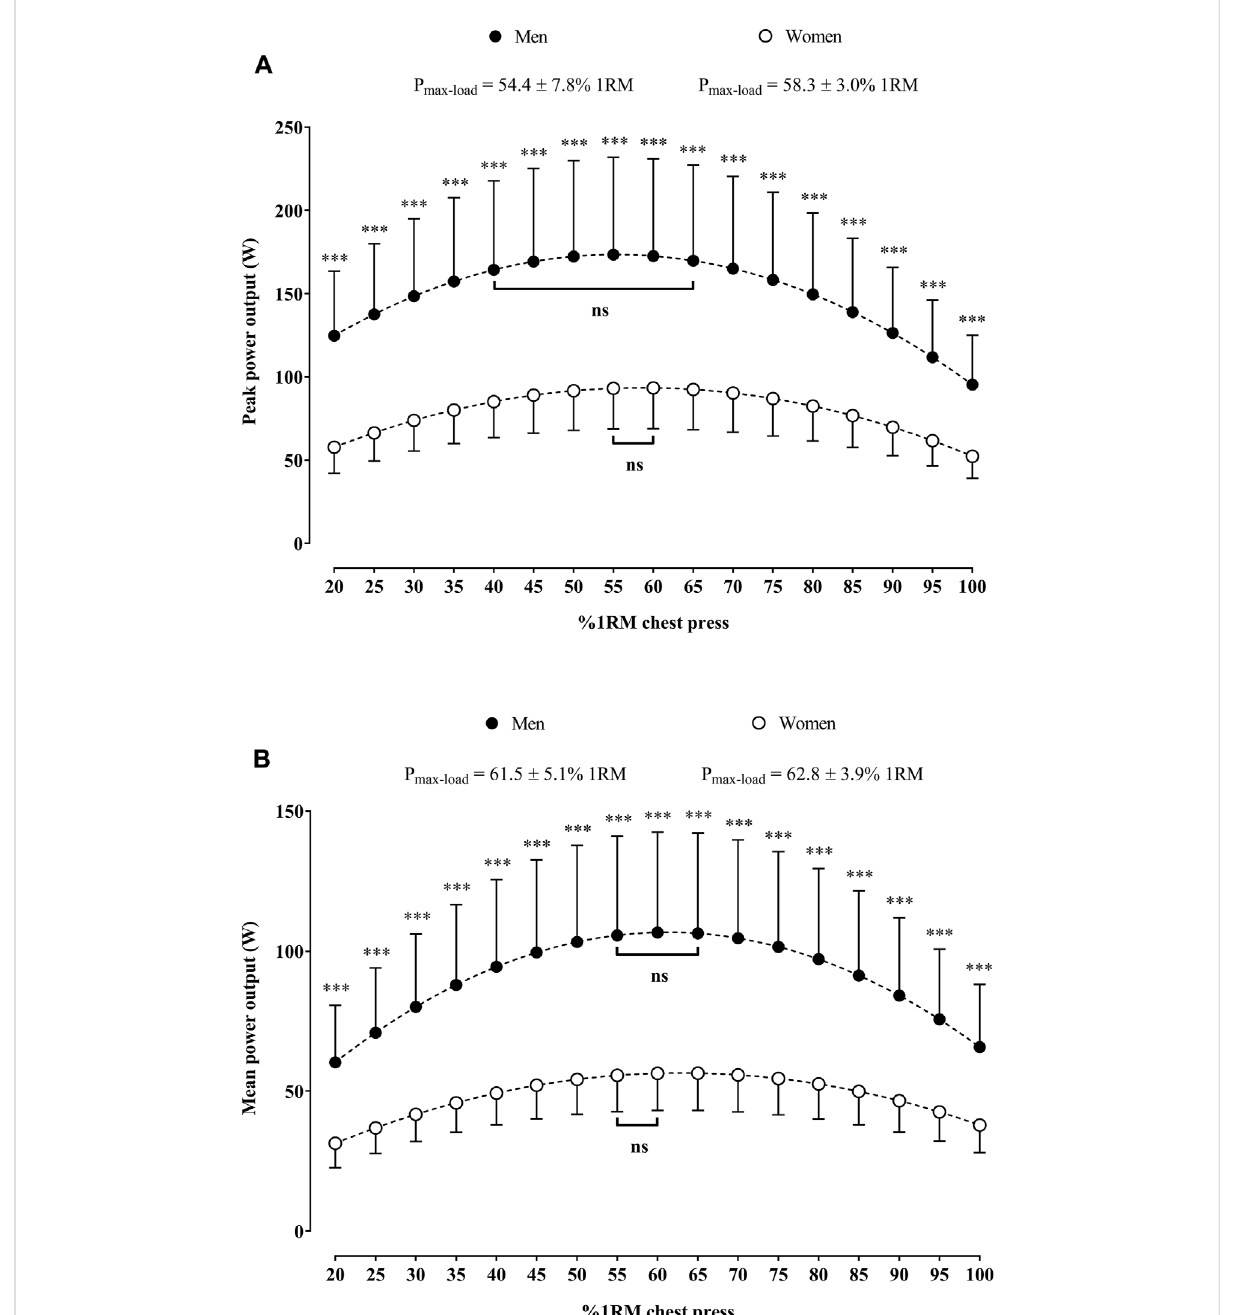
FIGURE 3 Load-peak (A) and mean power (B) relationships in the chest press for older women and men. * p < 0.05, ** p < 0.01, and *** p < 0.001 indicate signi fi cant differences between sexes in the absolute mean or peak power against the same relative load. Square brackets indicate the range of relative loads at which the power output was not statistically different (ns) than the P max-load . Abbreviation: P max-load , relative load that maximizes the power output; RM, repetition